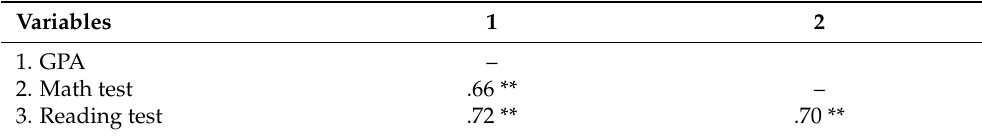
Table 3. Intercorrelations of the dependent Variables (Grade